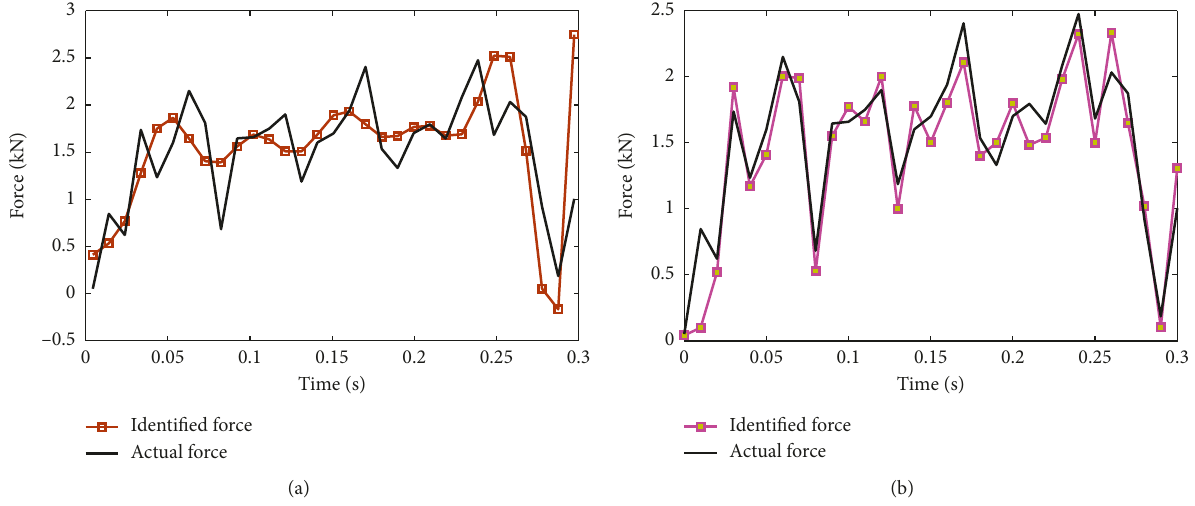
Figure 7: Different identified techniques using PSO-L: (a) MER technique and (b) IMER technique.